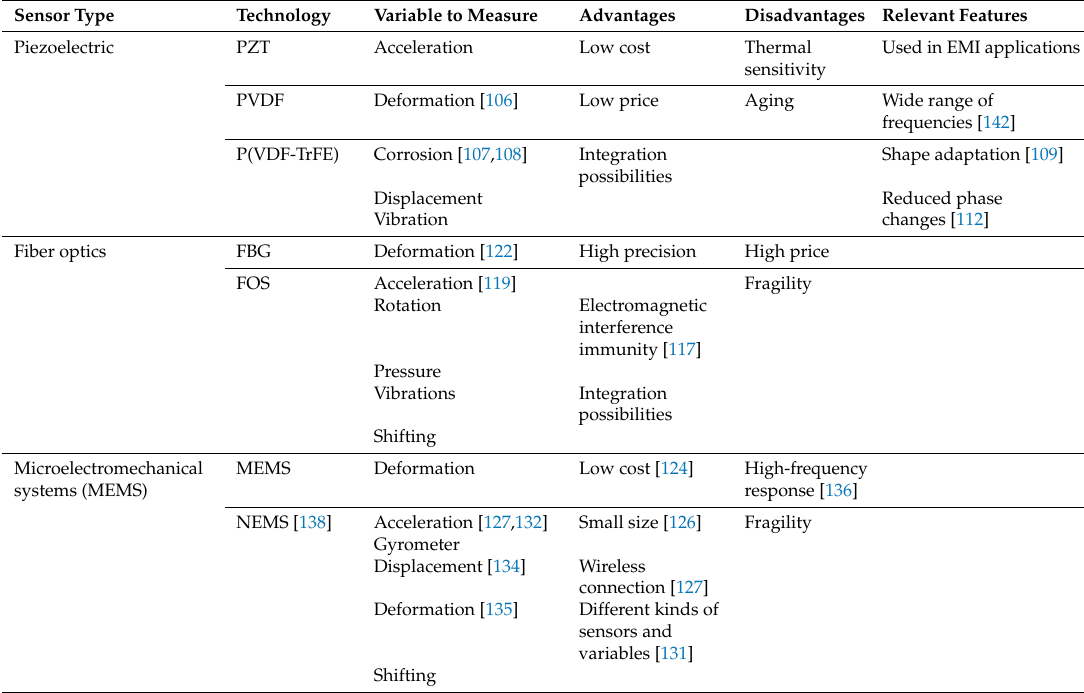
Table 1. Sensor types and